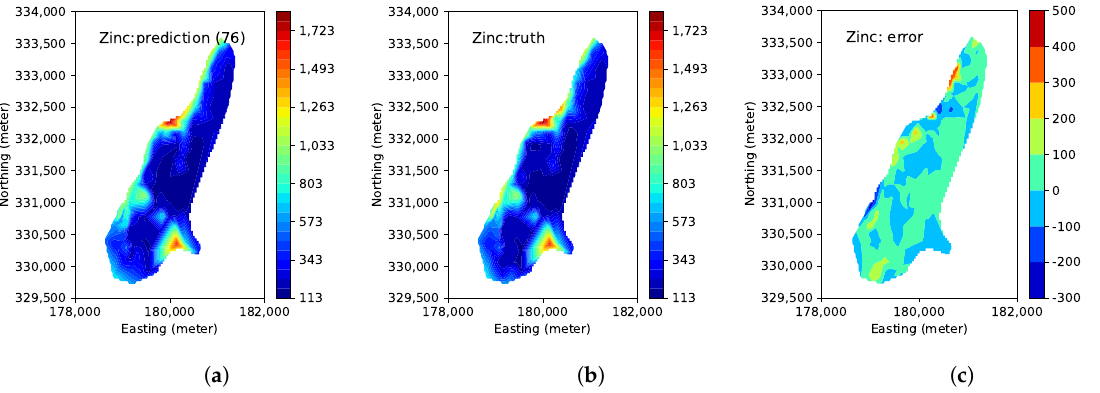
Figure 8. Predicted heavy concentration using the combined model, ground truth, and prediction error (i.e., y ∗ − y ). ( a ): predicted Zinc concentration in soil; ( b ): ground truth of Zinc concentration; and ( c ): prediction error of Zinc